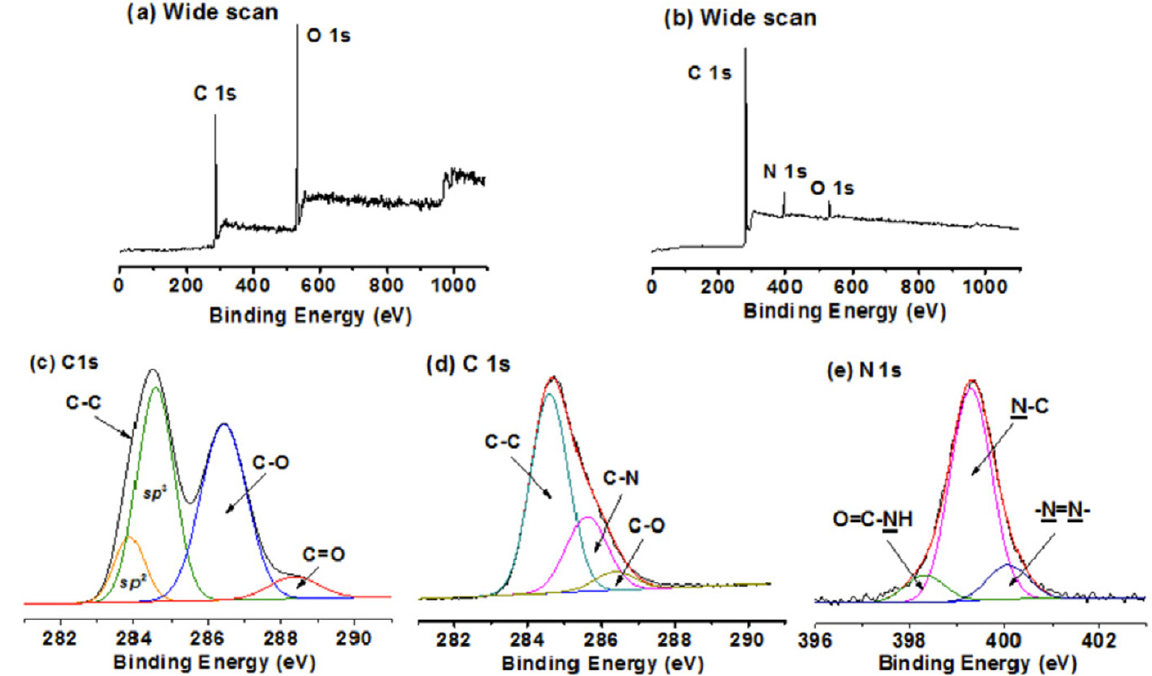
Figure 23. Wide scan and C1s core-level XPS spectra of ( a , c ) GO, and ( b , d ) PVK-AZO-GO; N1s core-level XPS spectra of € PVK-AZO-GO (Reprinted with permission from [107]; Copyright @ 2018 Elsevier).